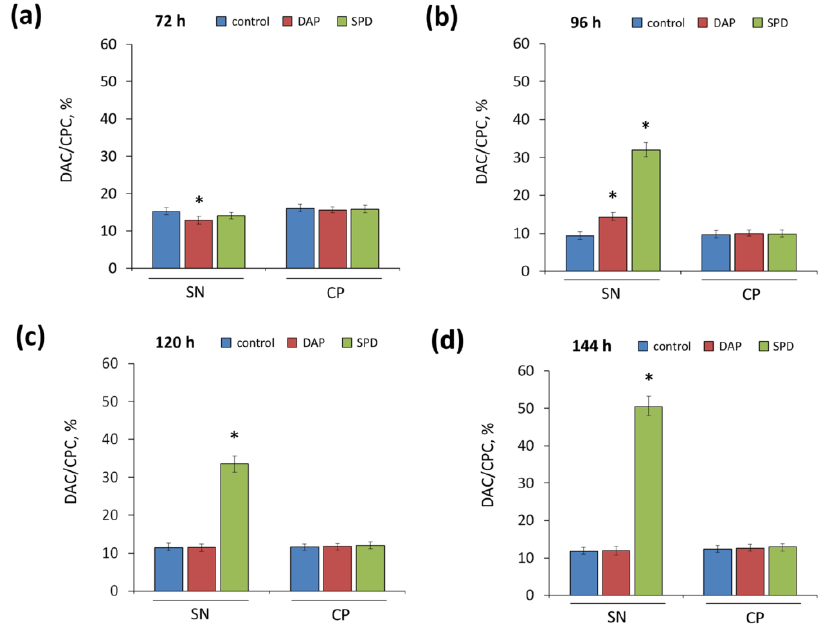
Figure 6. Relative DAC/CPC production (%) after cultivation of A. chrysogenum HY strain on synthetic (SN) and complex (CP) media with 5 mM 1,3-diaminopropane (DAP), or 5 mM spermidine (SPD), or without additions (control) for ( a ) 72 h; ( b ) 96 h; ( c ) 120 h; ( d ) 144 h. Data are means ± SD, n = 3. Statistical significance, * p ≤ 0.05, as compared with the control (strain, cultivated on medium without PAs additions).